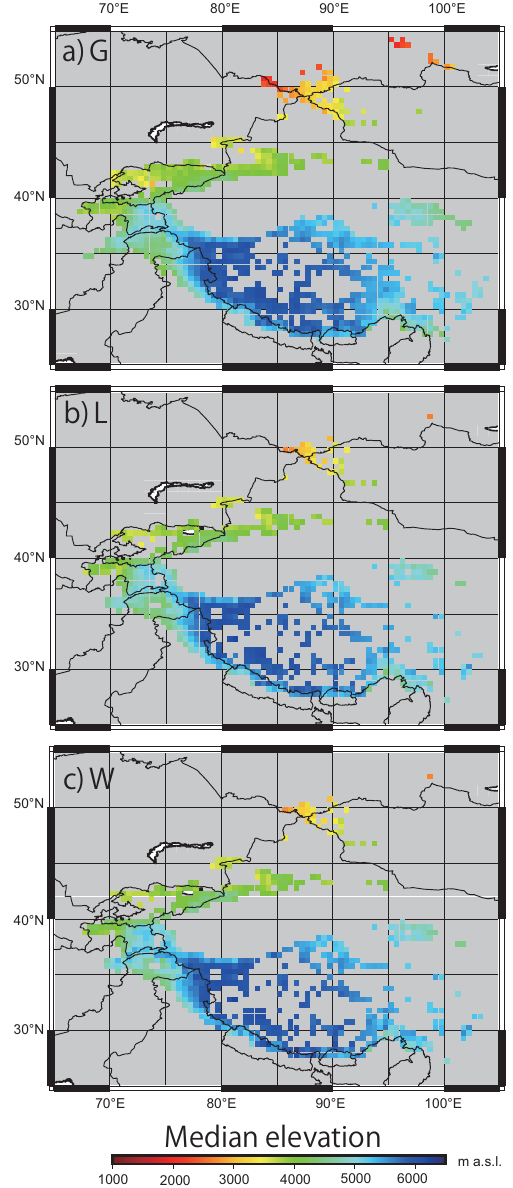
Figure 5. Distributions of (a) G-, (b) L-, and (c) W-average eleva- tion. These distributions are the area-weighted average of median elevations in each 0.5 ◦